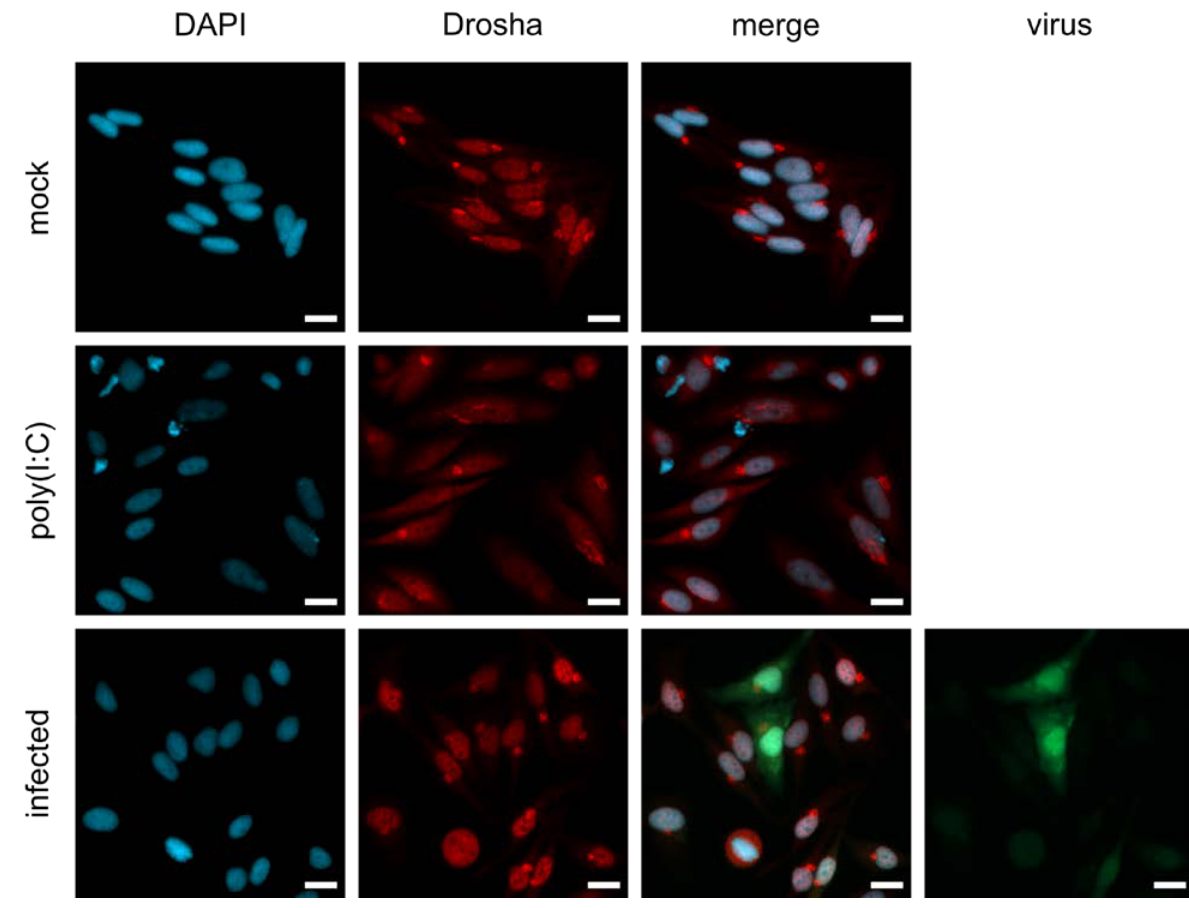
Figure 4. Localization of Drosha upon MeV infection. Nuclear localization experiments with immunofluorescence staining of Drosha. HeLa cells were mock-treated, and treated with 10 µg/mL poly(I:C) or infected with MeV ld-EGFP at MOI 0.3 (green). Drosha (red) and the nucleus (blue) were stained with antibody and DAPI, respectively. Bright spots in the Drosha staining are considered staining artifacts. Scale bar: 20 µm.